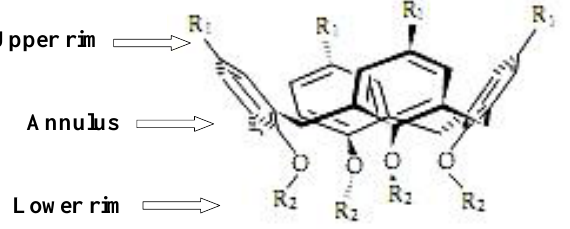
Figure 1. Division of calix[4]arene (applicable to all the calixarenes).